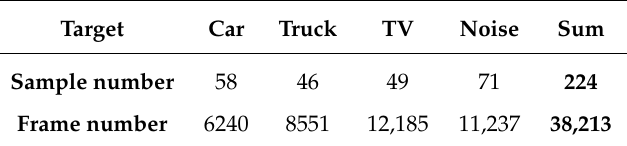
Table 3. The composition of our labeled sample